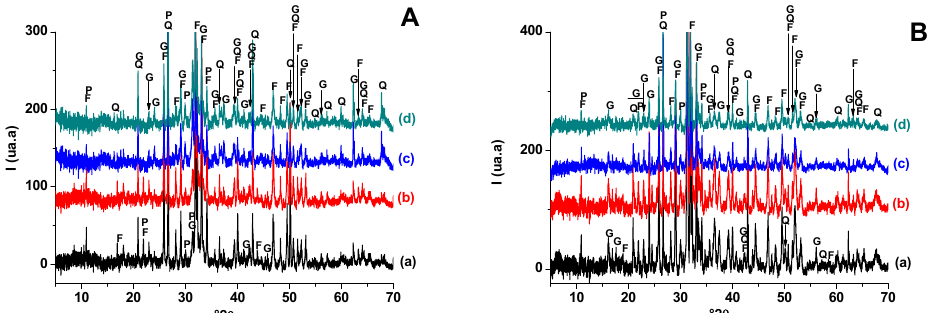
Figure 8. X-ray diffraction patterns of SA-PS (50 wt. % of SA) blends heated at 900 °C ( A ) and 1100 °C ( B ). (a) SA-PS; (b) SA-PS-SC (5 wt. % of SC); (c) SA-PS-SC (10 wt. % of SC); (d) SA-PS-SC (20 wt. % of SC). G: Gehlenite (PDF # 72-2128); Q: Quartz (PDF # 79-1911); F: Fluorapatite (PDF # 83-0556); P: Calcium phosphates (PDF # 11-0232).